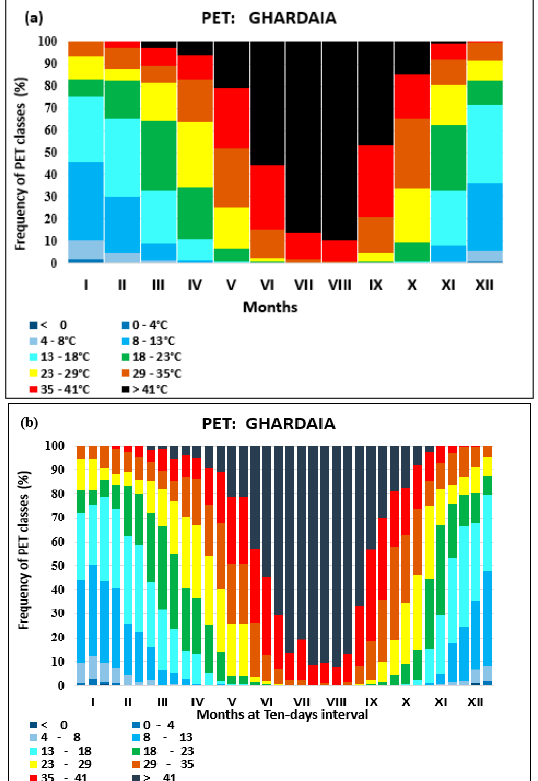
Figure 2. Bioclimatic diagram for Ghardaia for the period of 1986–2015; frequencies (%) of the nine different PET thermal grades perception classes for Monthly timescale resolution ( a ) and 10-day time interval period ( b ) of the mean year.